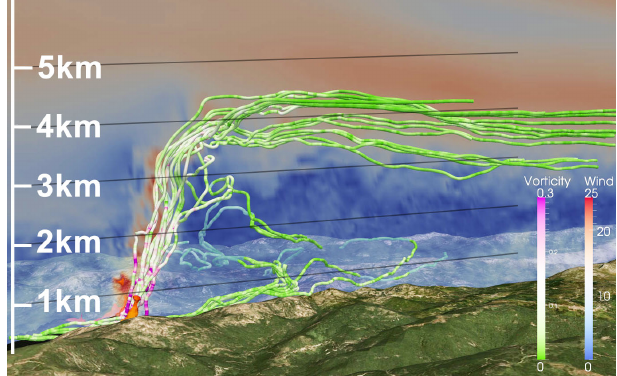
Figure 7. Vertical cross-section of the wind speed (in ms − 1 , between blue and red) and streamlines initiated at the ground and colored according to the vorticity (in s − 1 , between green and pink) at 1500